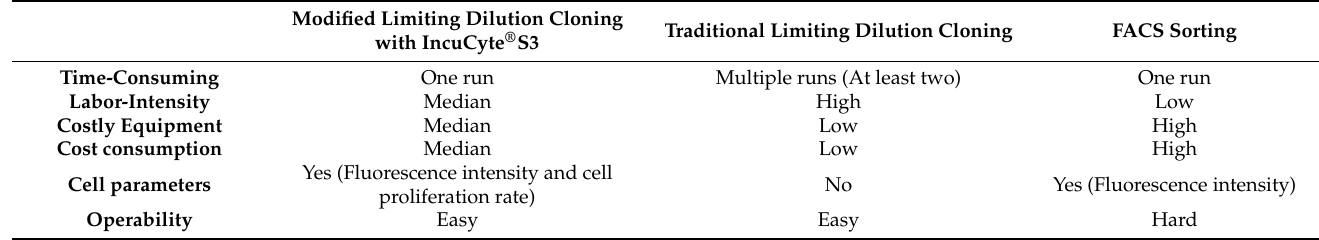
Table 1. Comparison of modified and traditional limiting dilution cloning and FACS sorting.